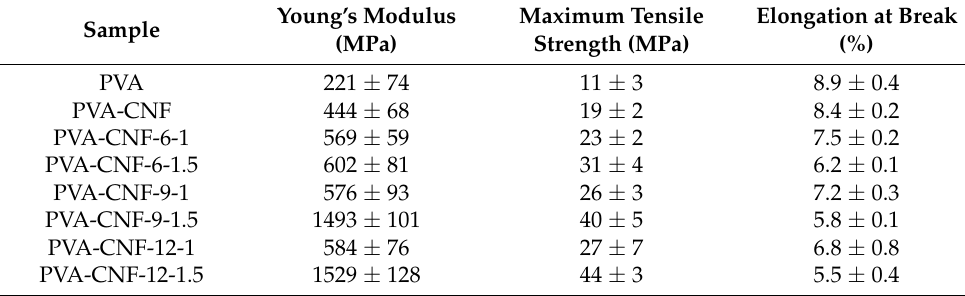
Table 4. Mechanical properties of neat PVA and PVA/CNF